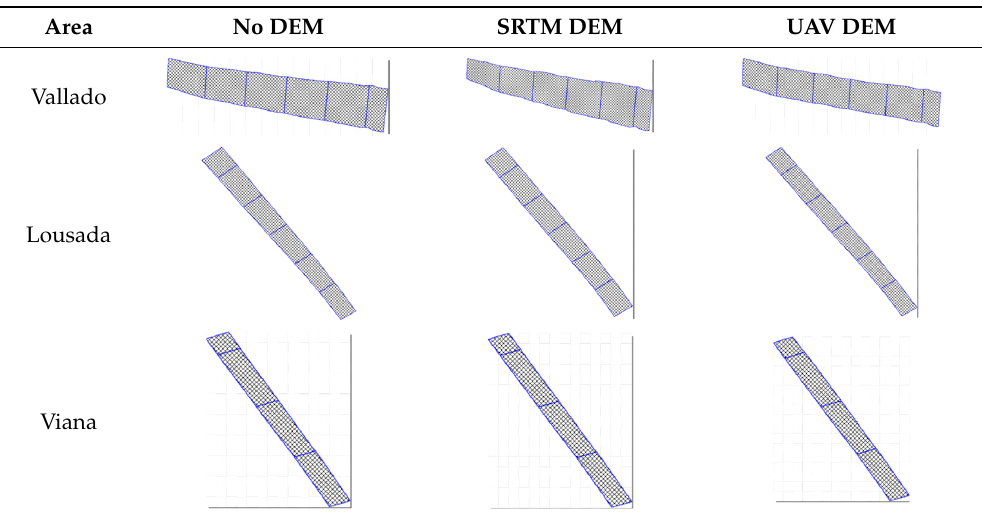
Table 5. Swath fit after orthorectification, in each study site, when using different digital elevation models (DEMs) or no DEM.